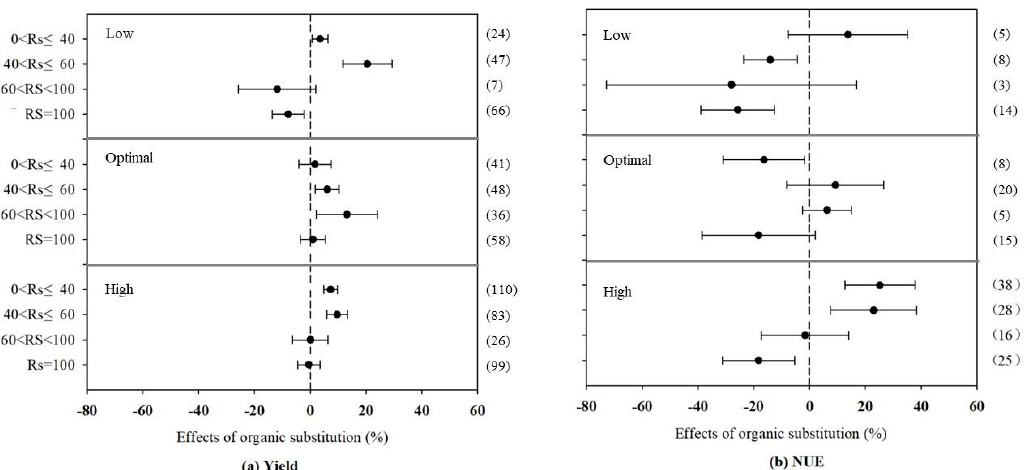
Figure 5. Effects of combined organic fertilizer substitution on maize yield ( a ) and nitrogen use efficiency (NUE) ( b ). Rs, substitution rate, defined as organic nitrogen (N) input/total N applied (%). See main text for definitions of low, optimal, and high fertilization rates. Error bars represent 95% confidence intervals. Numbers in parentheses indicate the numbers of observations.